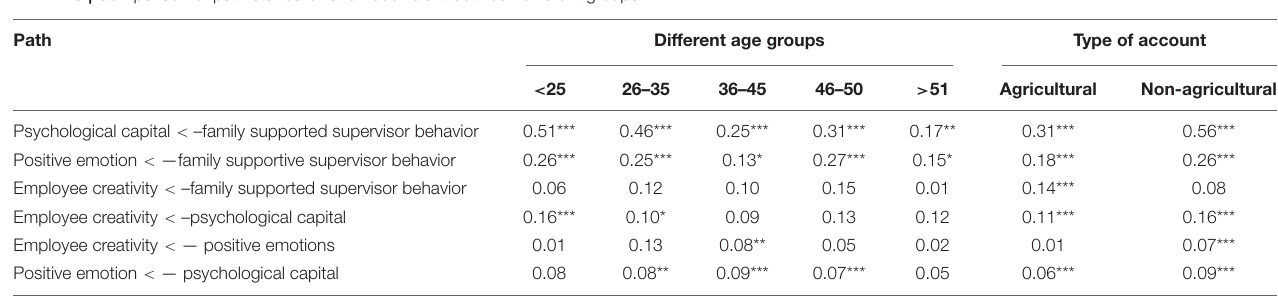
TABLE 8 | Comparison of path standardization coefficient between different